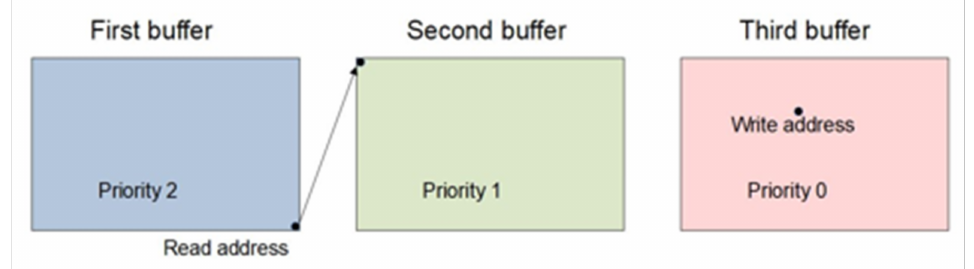
Figure 6. Buffer change for read process in triple